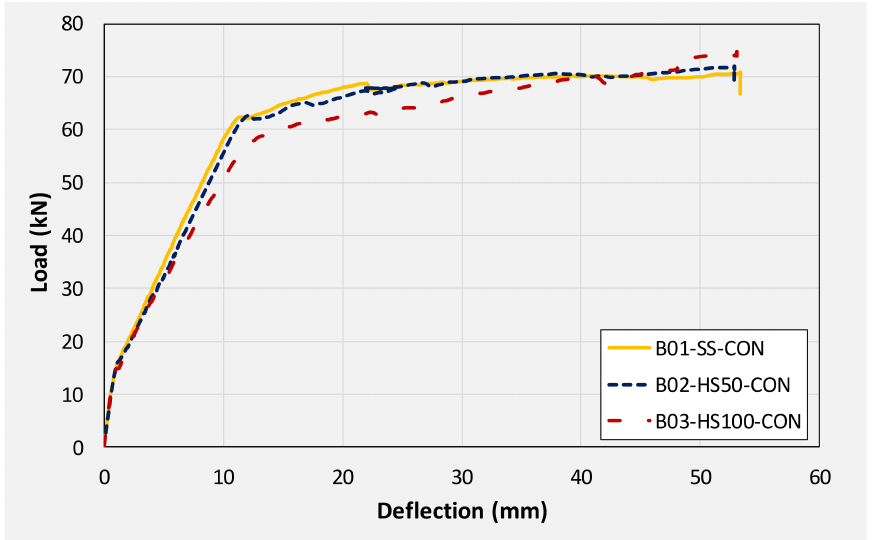
Figure 16. Comparison of load-deflection response of beams in 1st group (no CFRP strengthening).